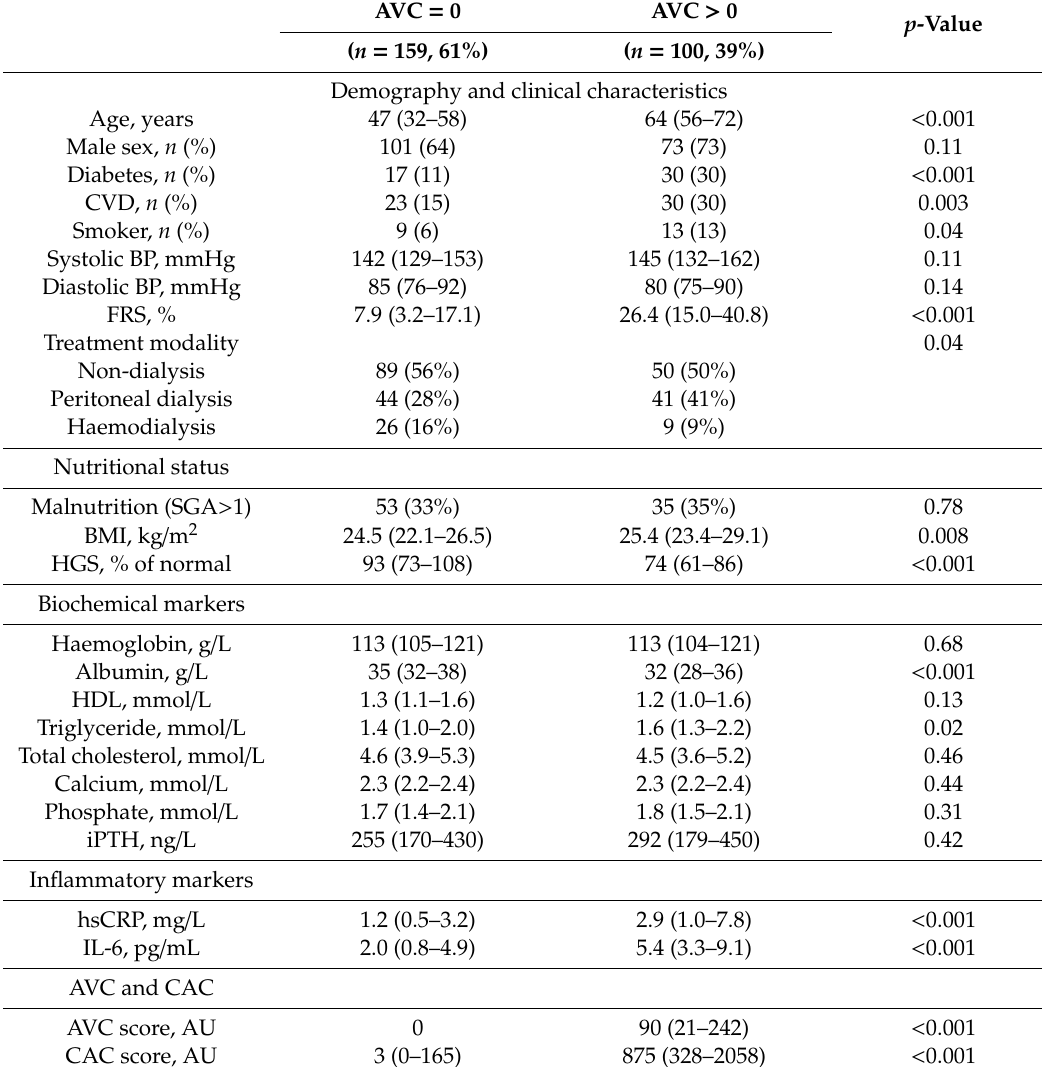
Table 1. Baseline clinical and biochemical characteristics in 259 ESRD patients according to the presence of AVC score. AVC =